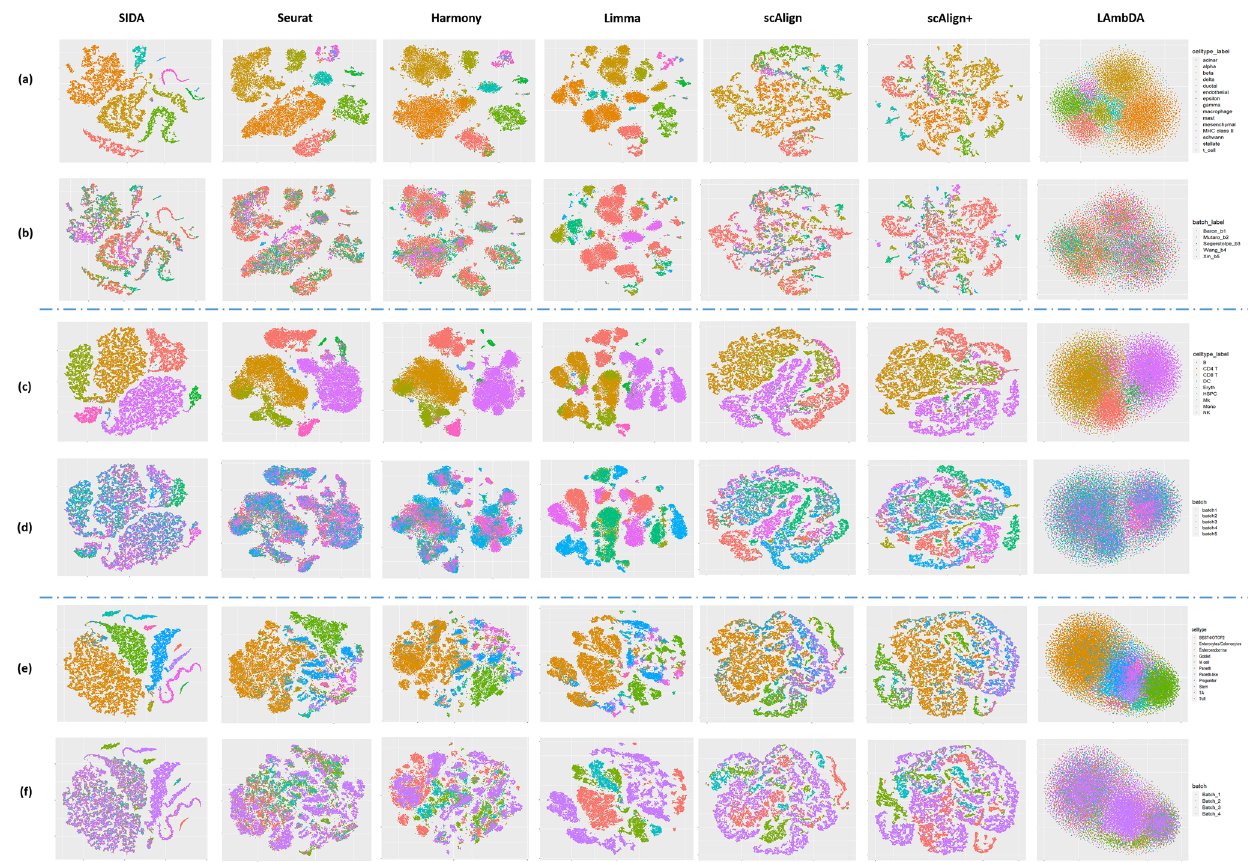
Fig. 2 tSNE visualization of SIDA, four unsupervised algorithms (Seurat, Harmony, Limma, scAlign) and two supervised algorithms (scAlign + and LAmbDA) applied to three data collections. a , b Integration of pancreas data collection colored by cell types and batch labels; c , d Integration of PBMC data collection colored by cell types and batch labels; e , f Integration of gut data collection colored by cell types and batch